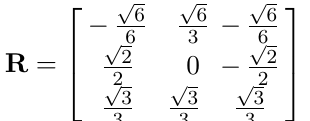
Figure 4 . Cubically inscribed tetrahedron with supermultiplets and their re-scaled p r coordinates at intersecting ( R )